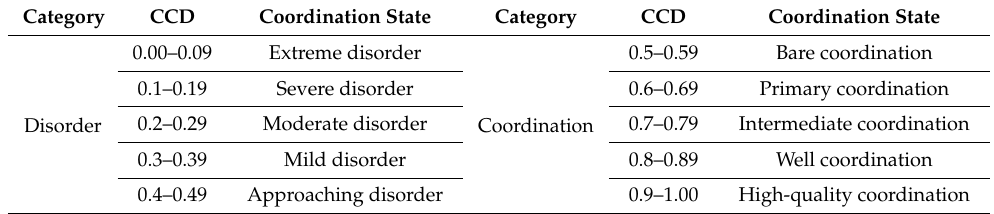
Table 2. The classification criteria of CCD of the TTE system.